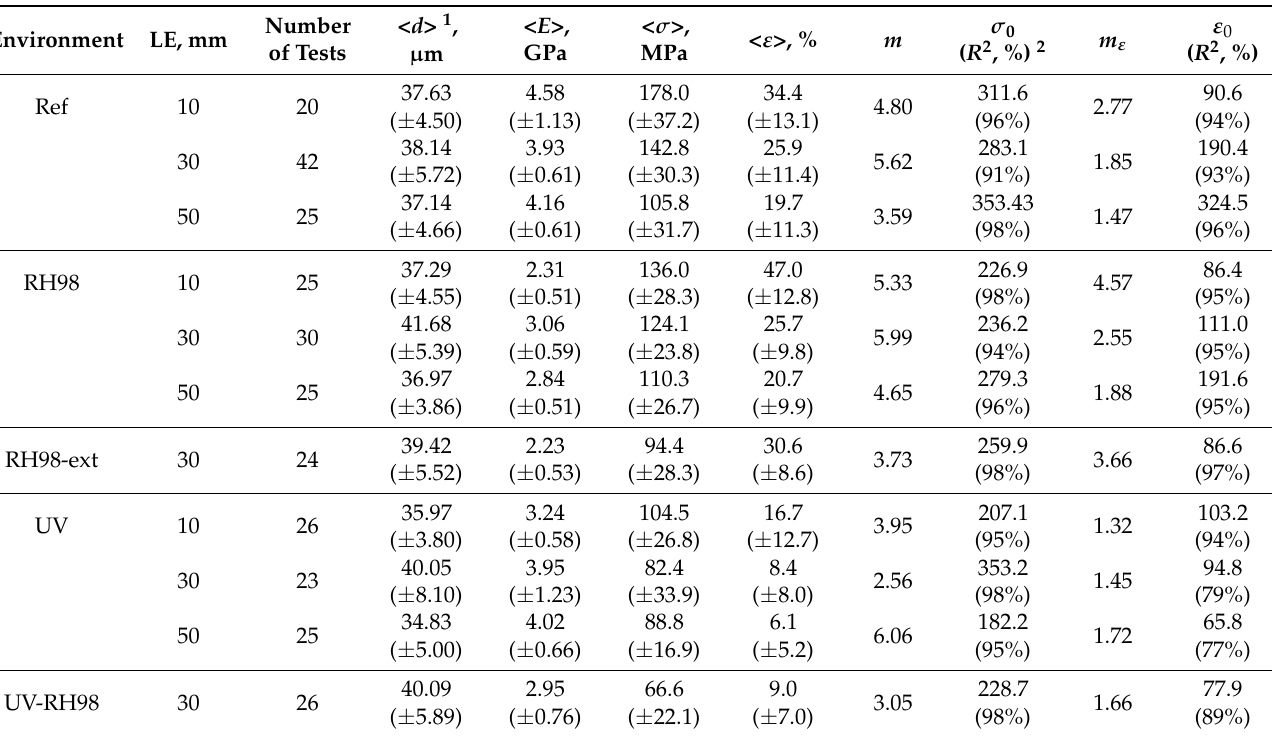
Table 2. Mechanical characteristics and Weibull distribution parameters of the wool fibers.